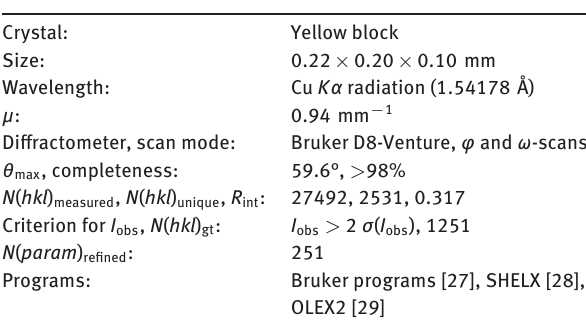
Table 1: Data collection and